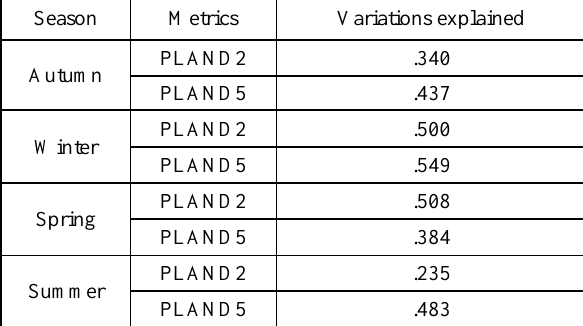
Table 3. Results of variance